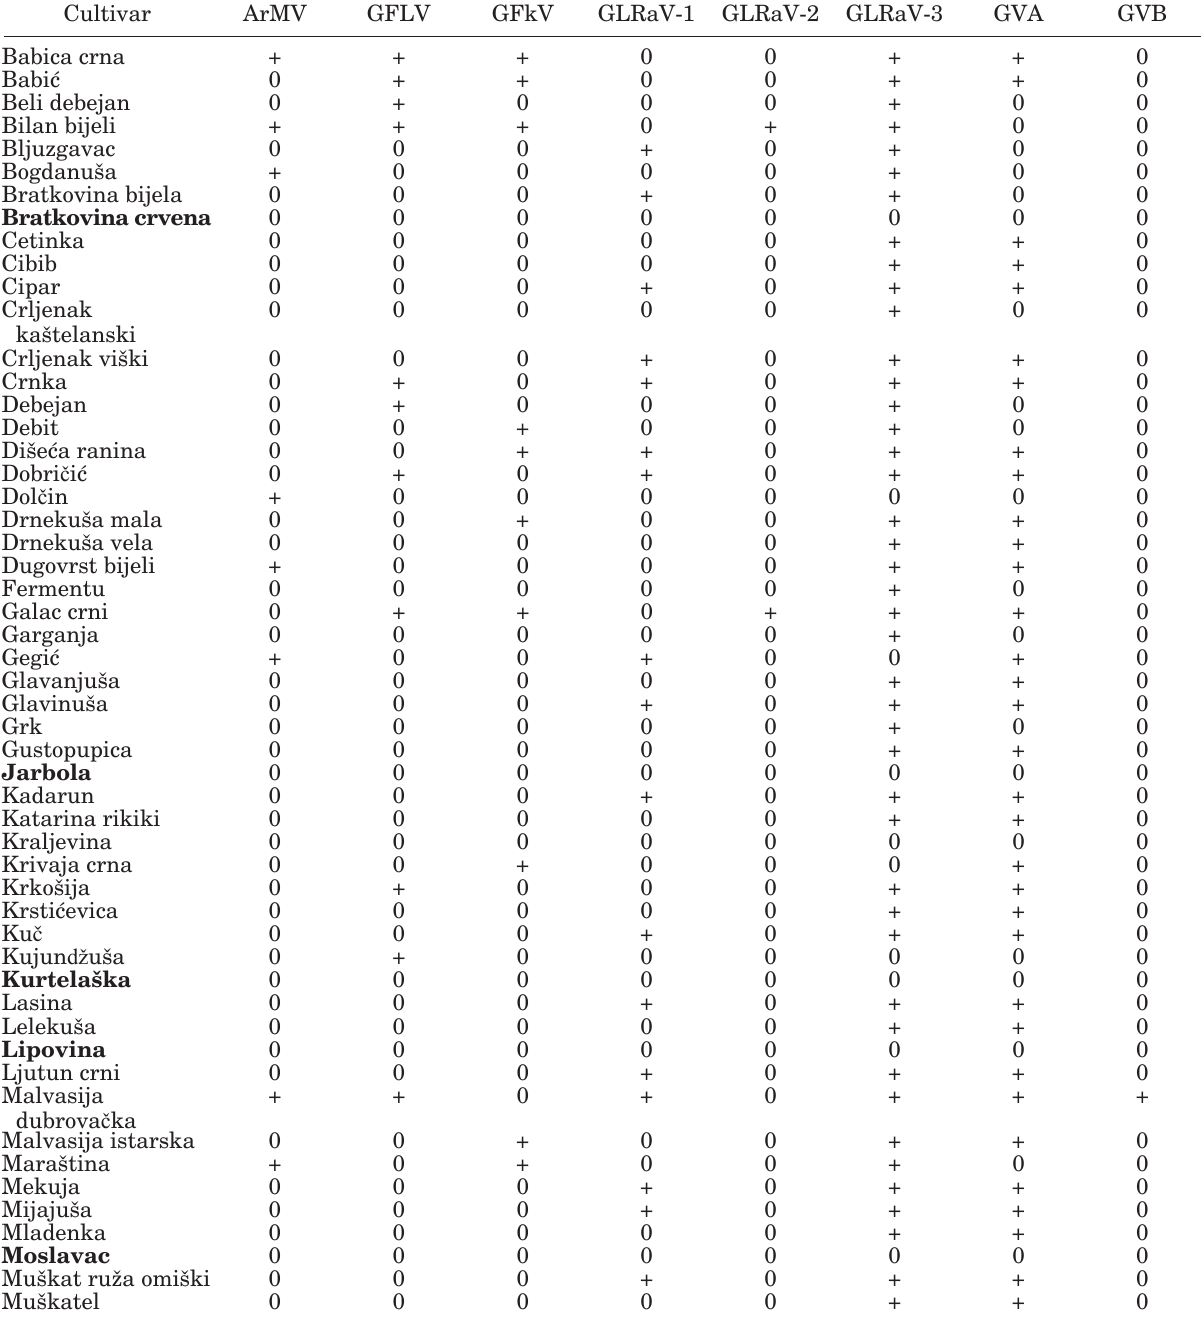
Table 1. Incidence of virus infections, determined by ELISA tests, in the National collection of Croatian native grape varieties. ArMV - Arabis mosaic virus , GFLV - Grapevine fanleaf virus , GFkV - Grapevine fl eck virus , GLRaV-1 - Grapevine leafroll-associated virus 1 , GLRaV-2 - Grapevine leafroll-associated virus 2 , GLRaV-3 - Grapevine leafroll- associated virus 3 , GVA - Grapevine virus A and GVB - Grapevine virus B . Cultivars in bold were free of all eight tested